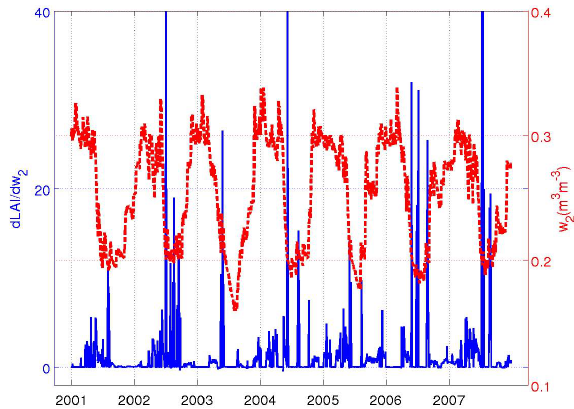
Fig. 5. Seasonal evolution of the Jacobian term for the observation operator ( ∂ LAI ) in blue together with the modeled w 2 (m 3 m − 3 ) in ∂w 2 red over the 7-year period